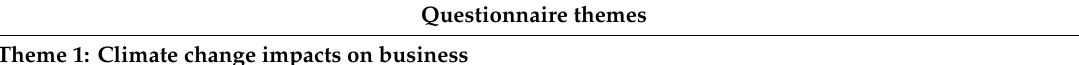
Table 1. Questions included in the survey questionnaire. Answering options given in